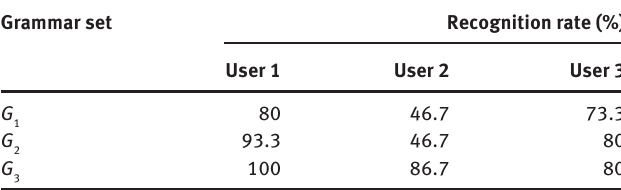
Table 3. Recognition Rates for Three Different Grammar